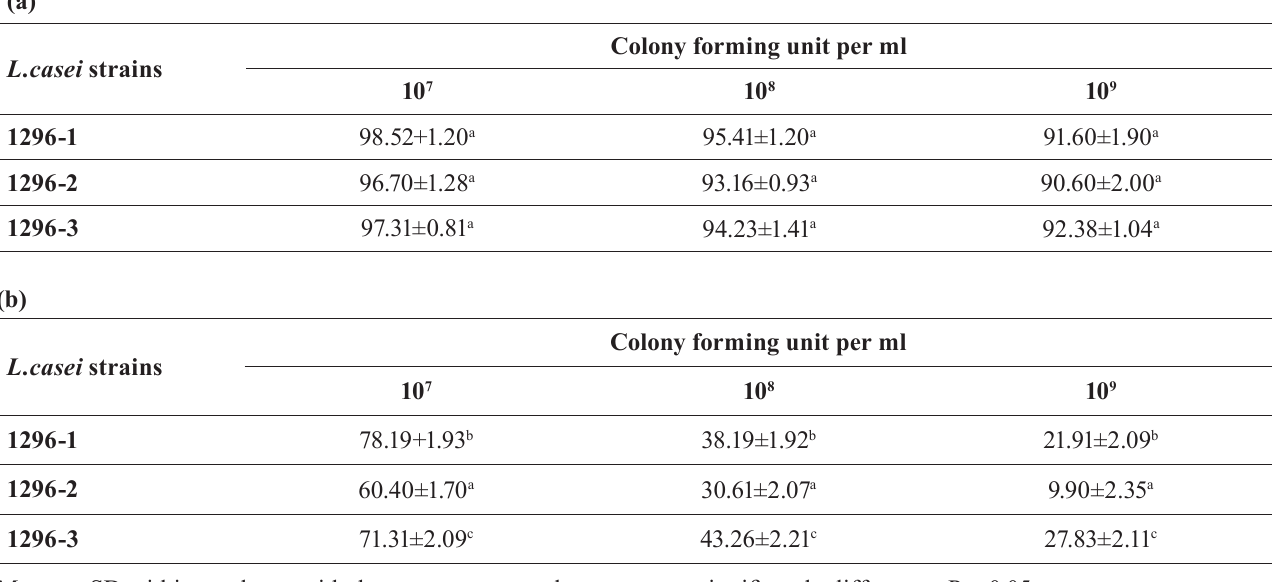
Means ± SD within a column with the same uppercase letters are not significantly different at P < 0.05. TABLE II - Cell viability of MRC 5 (a) and CaCo2 (b) cell lines after exposure of different concentrations of heat killed bacterial cells (Paraprobiotics) of the three L.casei strains, after 72 hrs by MTT assay (a)